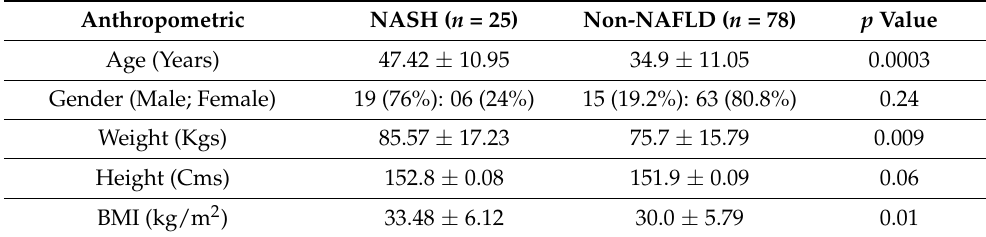
Table 4. Anthropometric measurements of the NASH and non-NAFLD subjects involved in this study. Anthropometric